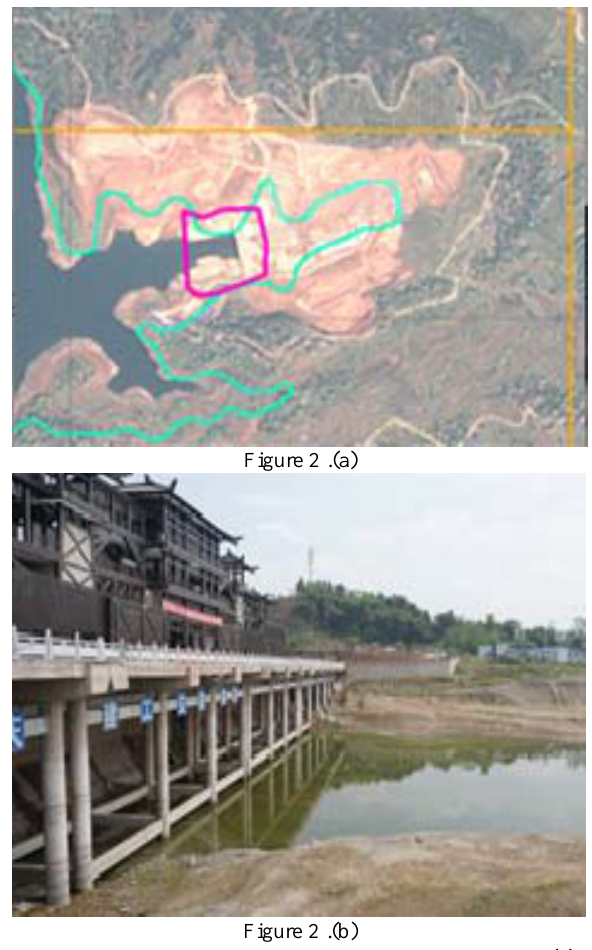
Figure 2. an example in the Three Gorges Reservoir Area: (a) a thematic map overlapping the satellite image collected in 2016, and (b) the manual inspection result in